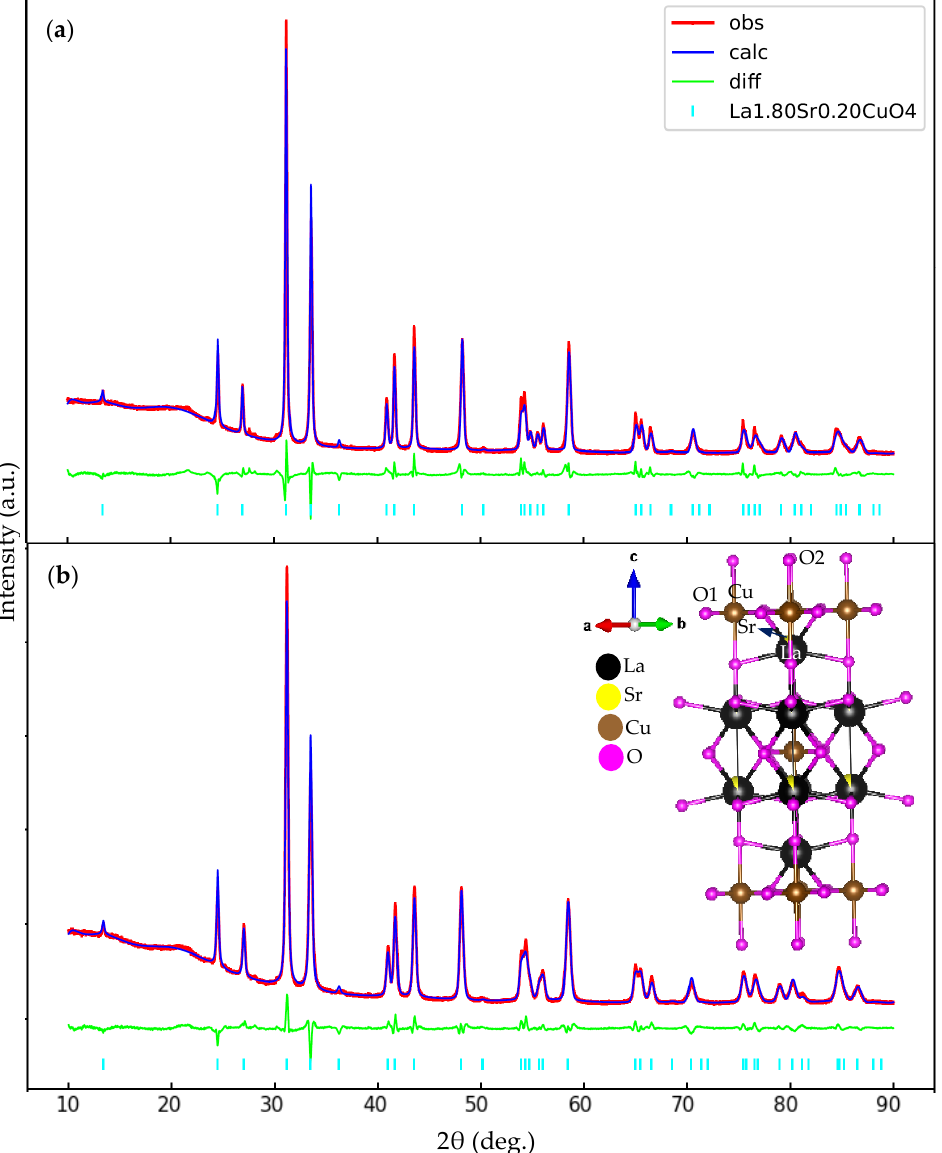
2 θ (deg.) Figure 1. Room temperature of XRD patterns of La 2 − x Sr x CuO 4 nanoparticles with x = 0.20 under different sintering conditions ( a ) sintering condition of 1073 K for 180 min ( b ) sintering condition of 973 K for 180 min. The inset depicts the schematic figure of the crystal structure of the sample. Table 1. Rietveld refinement structural parameters for La 2 − x Sr x CuO 4 nanoparticles with x = 0.20. Parameter